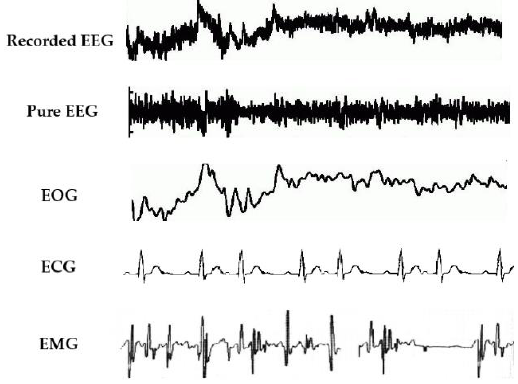
Figure 2. Physiological artifacts present in EEG signals.